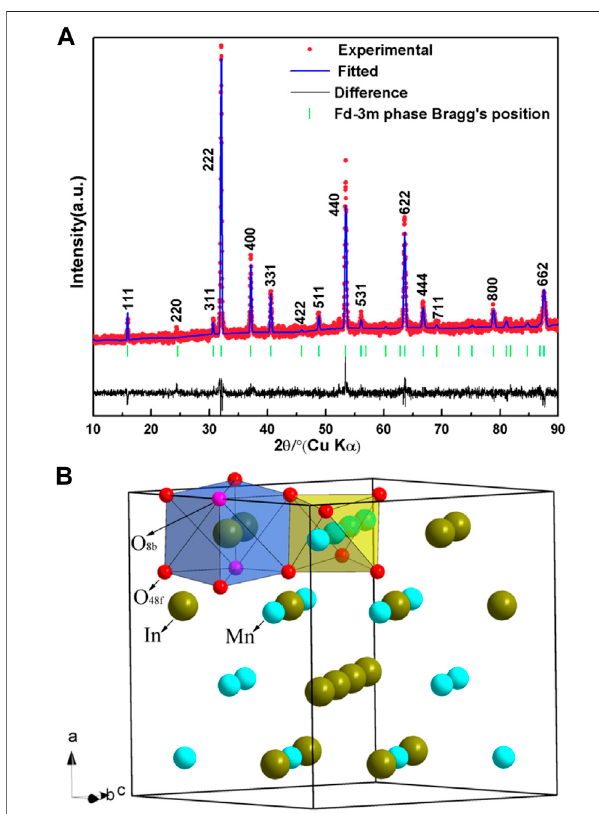
FIGURE 1 | (A) Rietveld full-pro fi le re fi nement of the diffraction patterns of In 2 Mn 2 O 7 at ambient condition. Red, blue, and black solid lines represent experimental, calculated, and residual patterns, respectively. Vertical markers show the calculated peak positions. (B) A schematic representation of the crystal structures of pyrochlore-type In 2 Mn 2 O 7 .